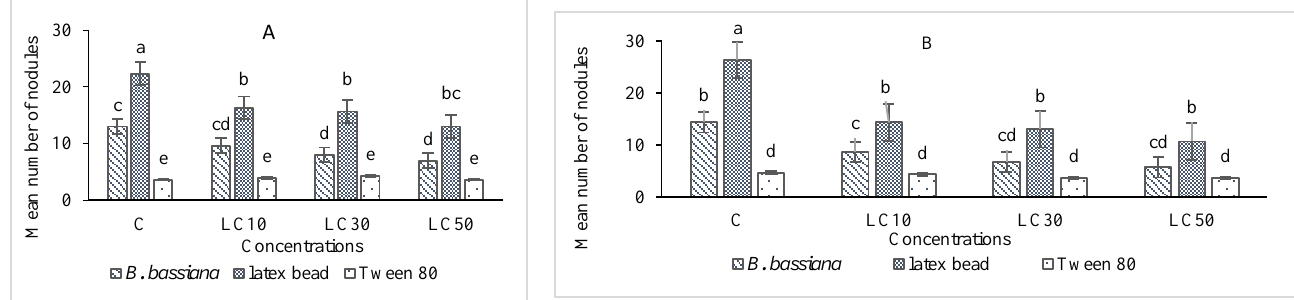
Figure 2. The effect of Artemisia annua floral essential oil on the plasmatocytes and granular cells of Glyphodes pyloalis larvae treated with oral ( A ) and fumigant ( B ) assays. Bars with different letters indicate significant differences among In each separate column, means followed by different letters indicate significant differences at p < 0.05 according to Tukey’s test. means of each hemocyte at p < 0.05, Tukey’s test. The number of hemocytes ×10 4 .